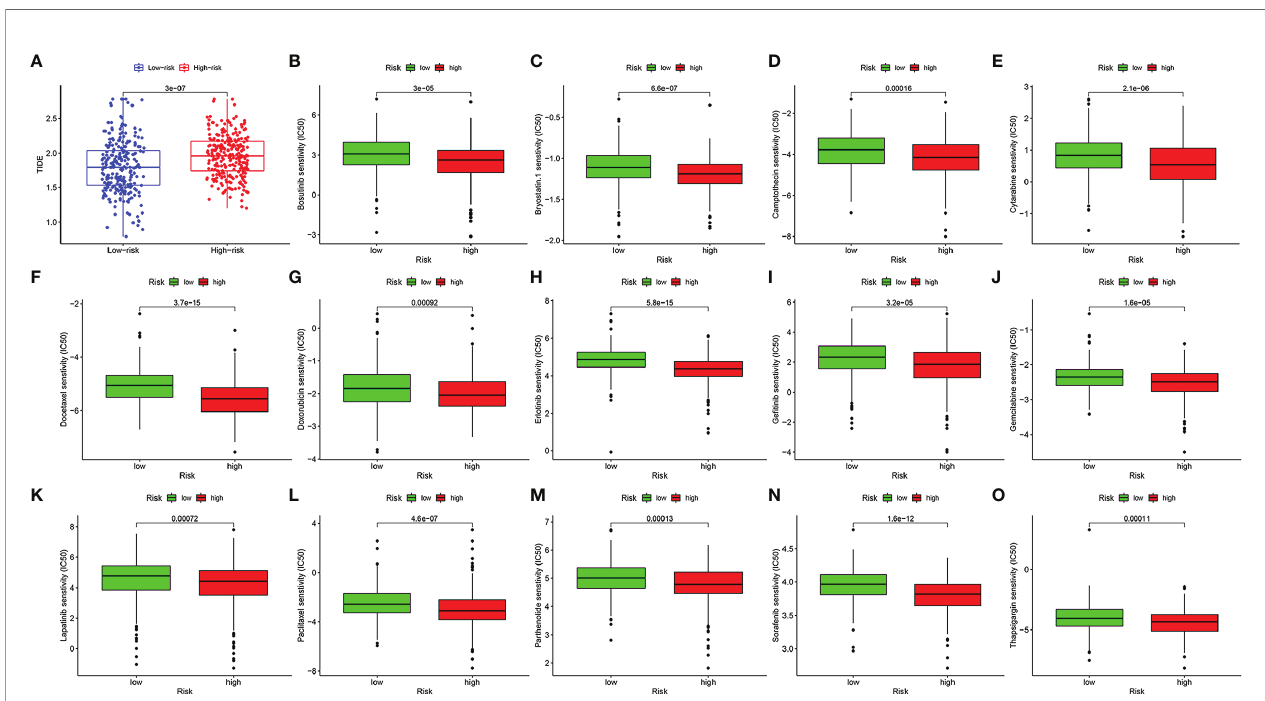
FIGURE 10 | The value of the risk model in predicting the ef fi cacy of immunotherapy and chemotherapy. The score of tumor immune dysfunction and exclusion of patients with head and neck squamous cell carcinoma (HNSCC) in high- and low-risk groups (A) . The box plots of the estimated IC50 for bosutinib (B) , bryostatin.1 (C) , camptothecin (D) , cytarabine (E) , docetaxel (F) , doxorubicin (G) , erlotinib (H) , ge fi tinib (I) , gemcitabine (J) , lapatinib (K) , paclitaxel (L) , parthenolide (M) , sorafenib (N), and thapsigargin (O)